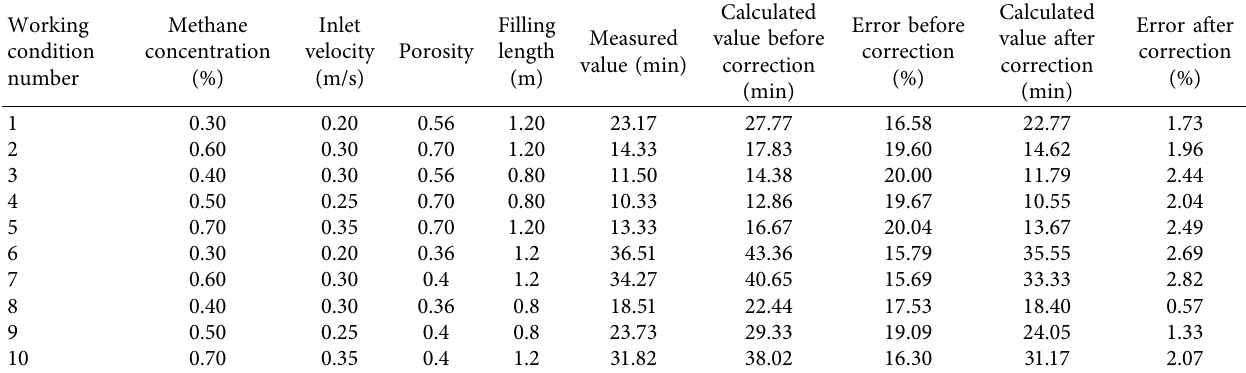
Table 3: Comparison of experimental and calculated values of the maximum commutation half